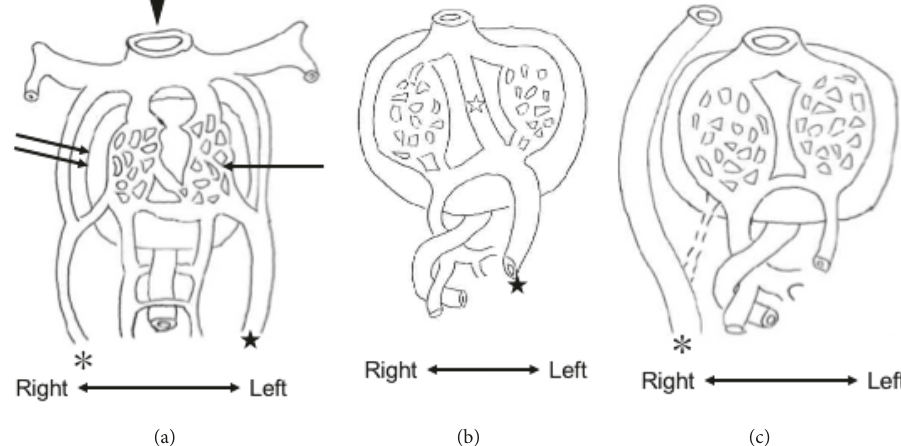
Figure 3: Proposed model of development in a patient with absent ductus venosus. (a) Normal fetal abdominal development at 5 weeks of gestation. Situs (arrowhead), hepatoblast (double arrows), liver sinusoid (arrow), left umbilical vein (black star), and right umbilical vein (asterisk) were indicated. (b) Normal development at 8 weeks of gestation. The right umbilical vein had regressed. Ductus venosus (DV) (white star) formed following development of the left umbilical vein (black star). (c) Abdominal development in a patient with extrahepatic absent ductus venosus at 8 weeks of gestation. The right umbilical vein (asterisk) persists and, thus, the flow of the left umbilical vein has decreased. Consequently, DV has not